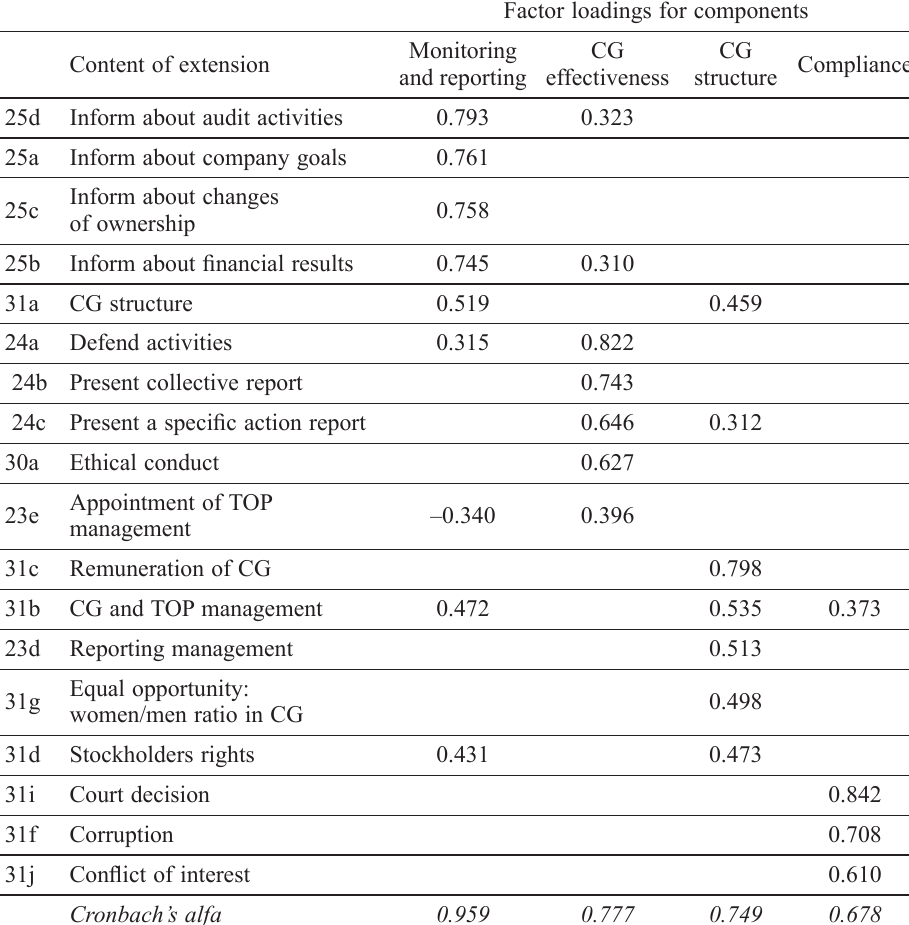
Table 6. Rotated component matrix for the extension contents Factor loadings for